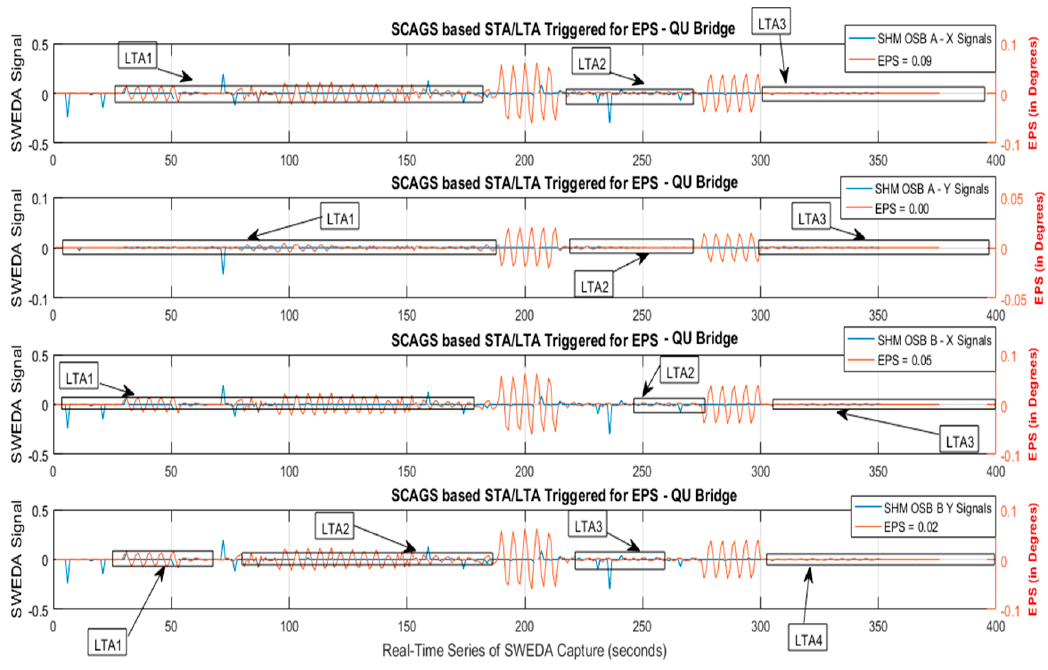
Figure 24. Earthquake probabilistic sequence (EPS) for the assumed dataset (down-sampled to 400).